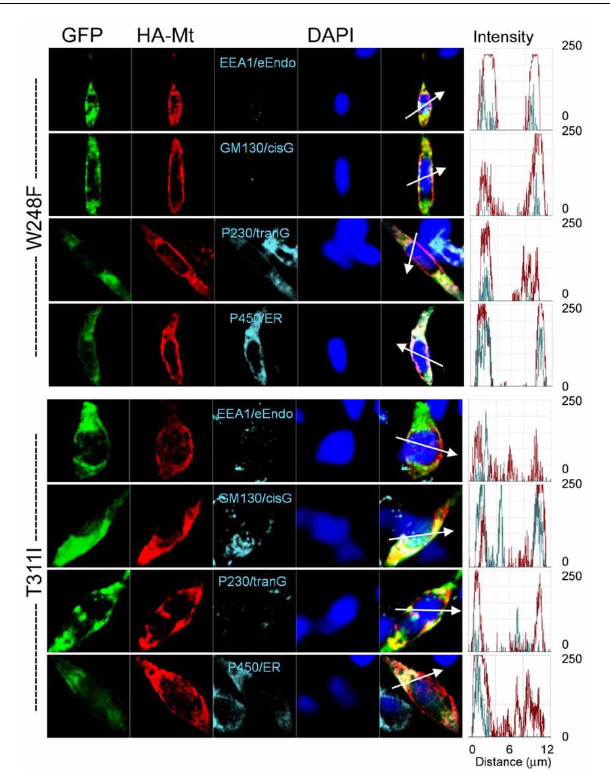
FIGURE 10 | Detection of subcellular localization of mutant hKv7.1 channels. HA-tagged MT Kv7.1 channels and subcellular organelles were double-stained in permeabilized cells ( P450/ER , anti-cytochrome P450 as endoplasmic reticulum marker; P230/tranG , anti-golgin A4 (P230) as trans-Golgi marker; GM130/cisG , anti-golgin A2 (Golgi matrix protein of 130kDa) as cis-Golgi marker; EEA1/e-Endo , anti-early endosome antigen 1 as endosome marker). Fluorescent intensities of MT hKv7.1 ( red ) and subcellular organelles ( cyan ) were plotted against the distance, which was marked in a merged image with a white arrow . The overlap pattern of red and cyan signals showed different levels of co-localization between